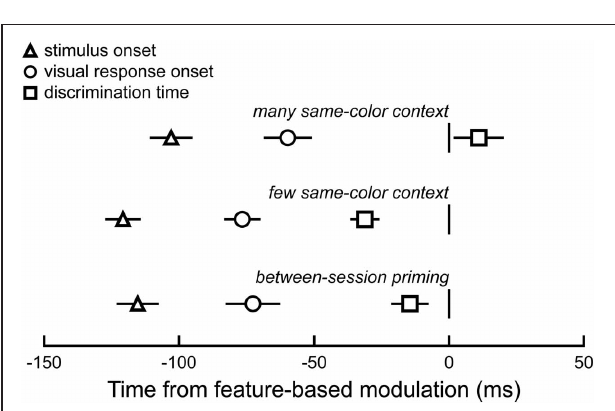
FIGURE 5 | Time course of feature-based modulation. Mean ± SE stimulus onset, visual response onset, and discrimination time with respect to time at which feature-based modulation was significant (i.e., 0ms; p < 0 . 05, rank-sum test). Feature sensitivity in many (top) and few (middle) same-color context displays, as well as between-session feature priming